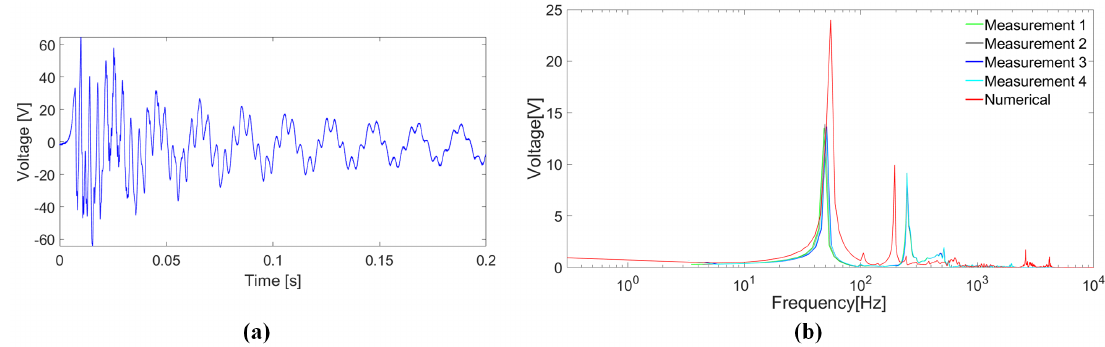
Figure 11. Open-circuit output voltage obtained during the STB test (model B): measured time history ( a ), Fourier transform of the signals compared to the numerical outcomes ( b